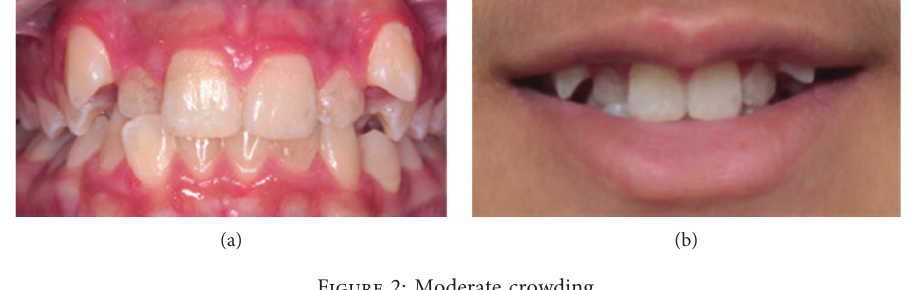
Figure 1: Mild crowding.